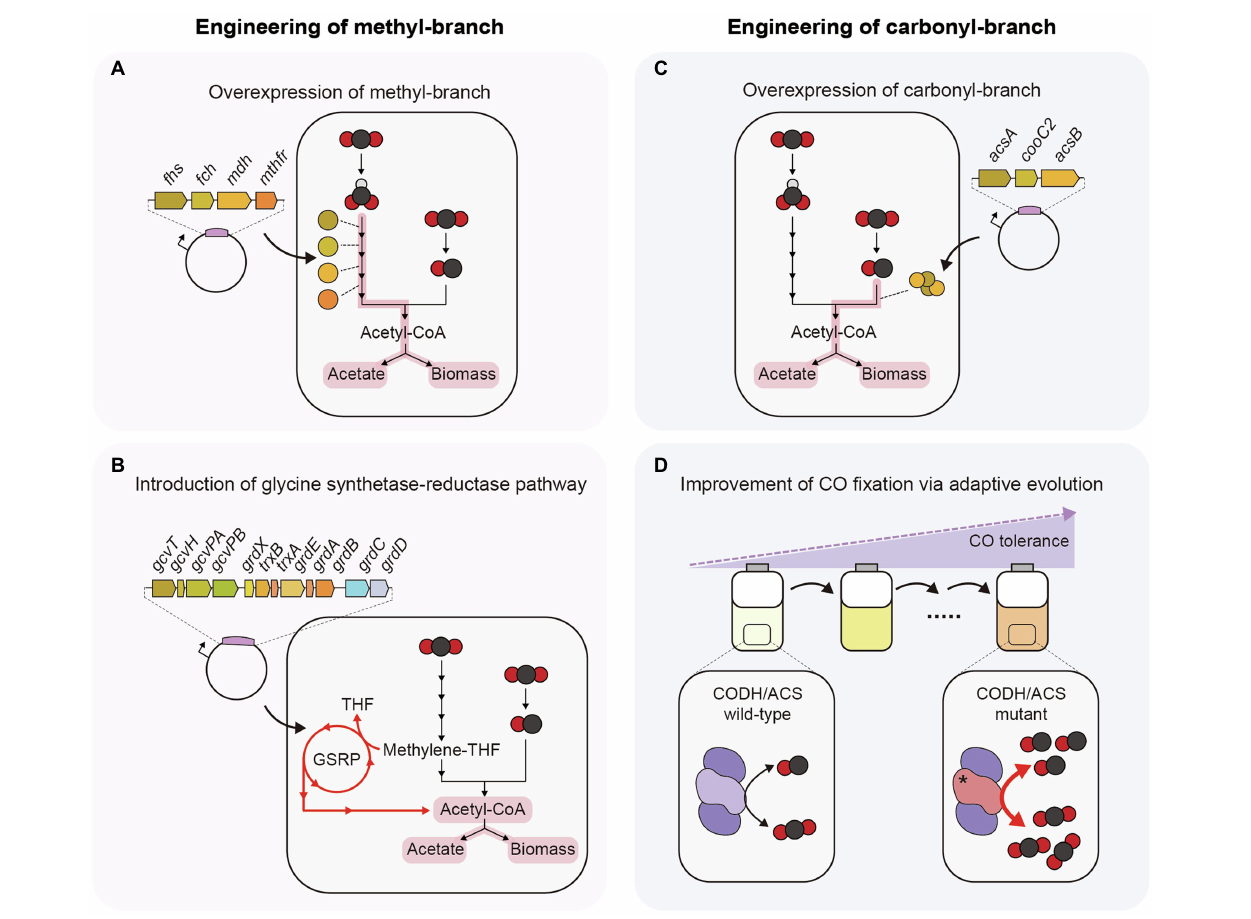
FIGURE 2 | Strategies to enhance efficiency of C1 gas fixation in acetogens. (A) Plasmid-based overexpression of THF-dependent enzymes. (B) Introduction of glycine synthase-reductase pathway. (C) Plasmid-based overexpression of CODH, ACS, and CooC2. (D) CODH/ACS mutant obtained from adaptive laboratory evolution under a high concentration of CO. GSRP, Glycine synthase-reductase